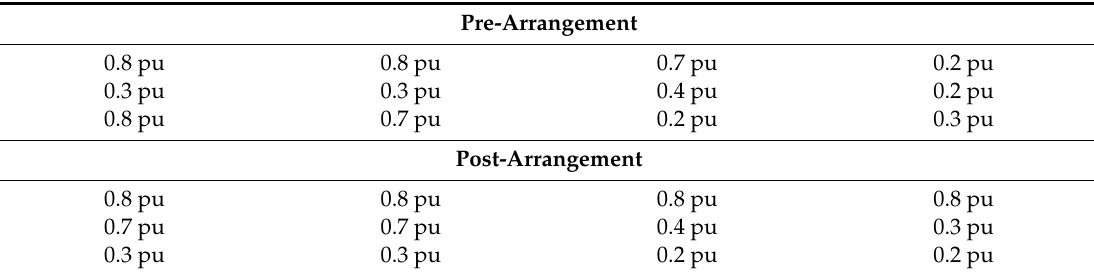
Table 2. PV Array Pre-Post rearrangements.